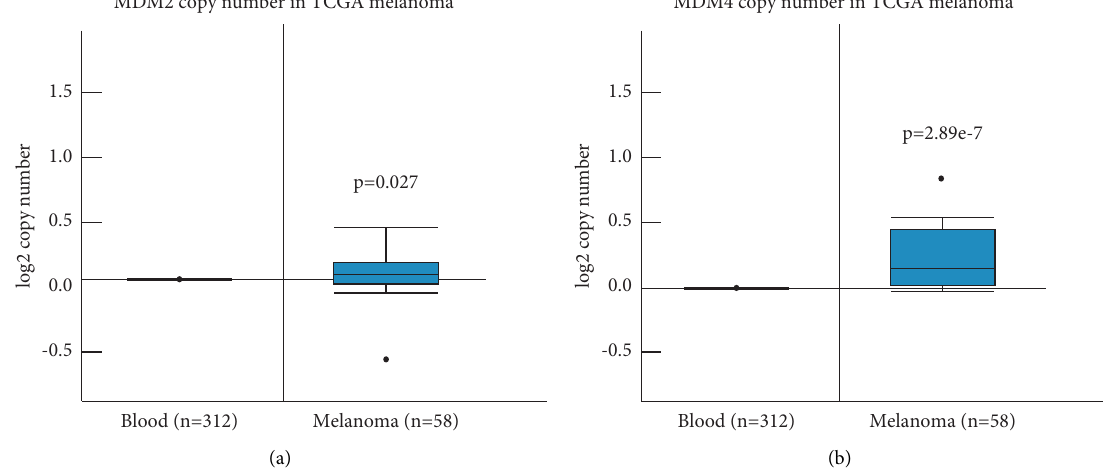
Blood (n=312) Melanoma Figure 2: MDM4 is frequently amplified in melanoma, in contrast with MDM2. Skin cutaneous melanoma data from TCGA with copy number data available for tumor and matched normal tissue (blood) were analyzed for amplification or deletion of the genes MDM2 (a) and MDM4 (b). Copy number is relative to the control blood